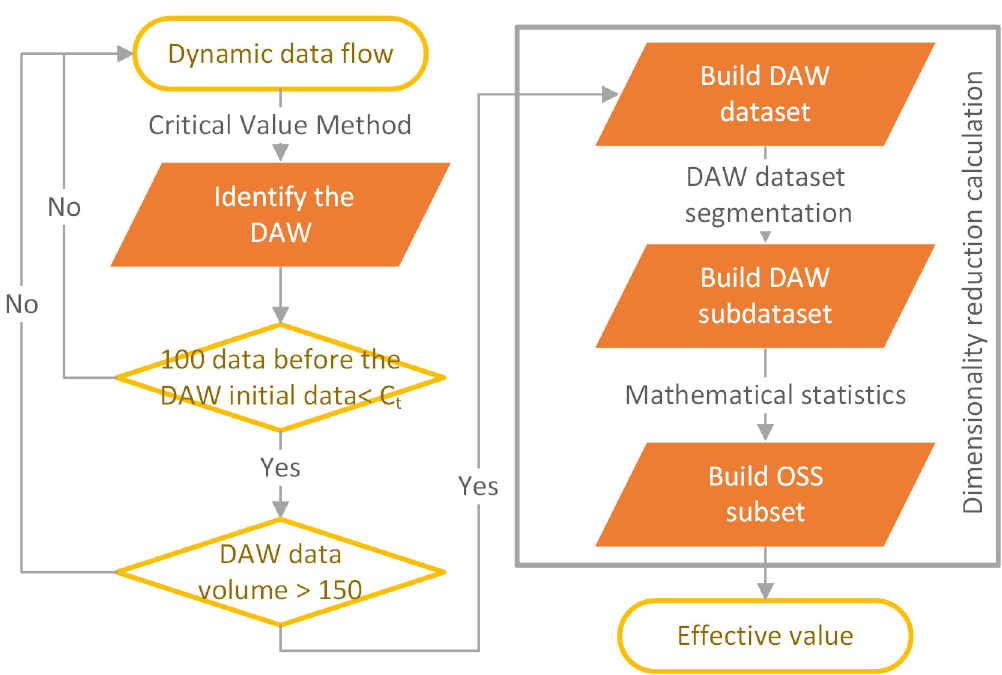
Fig 5. Effective Value Calculation (EVC) model calculation flow